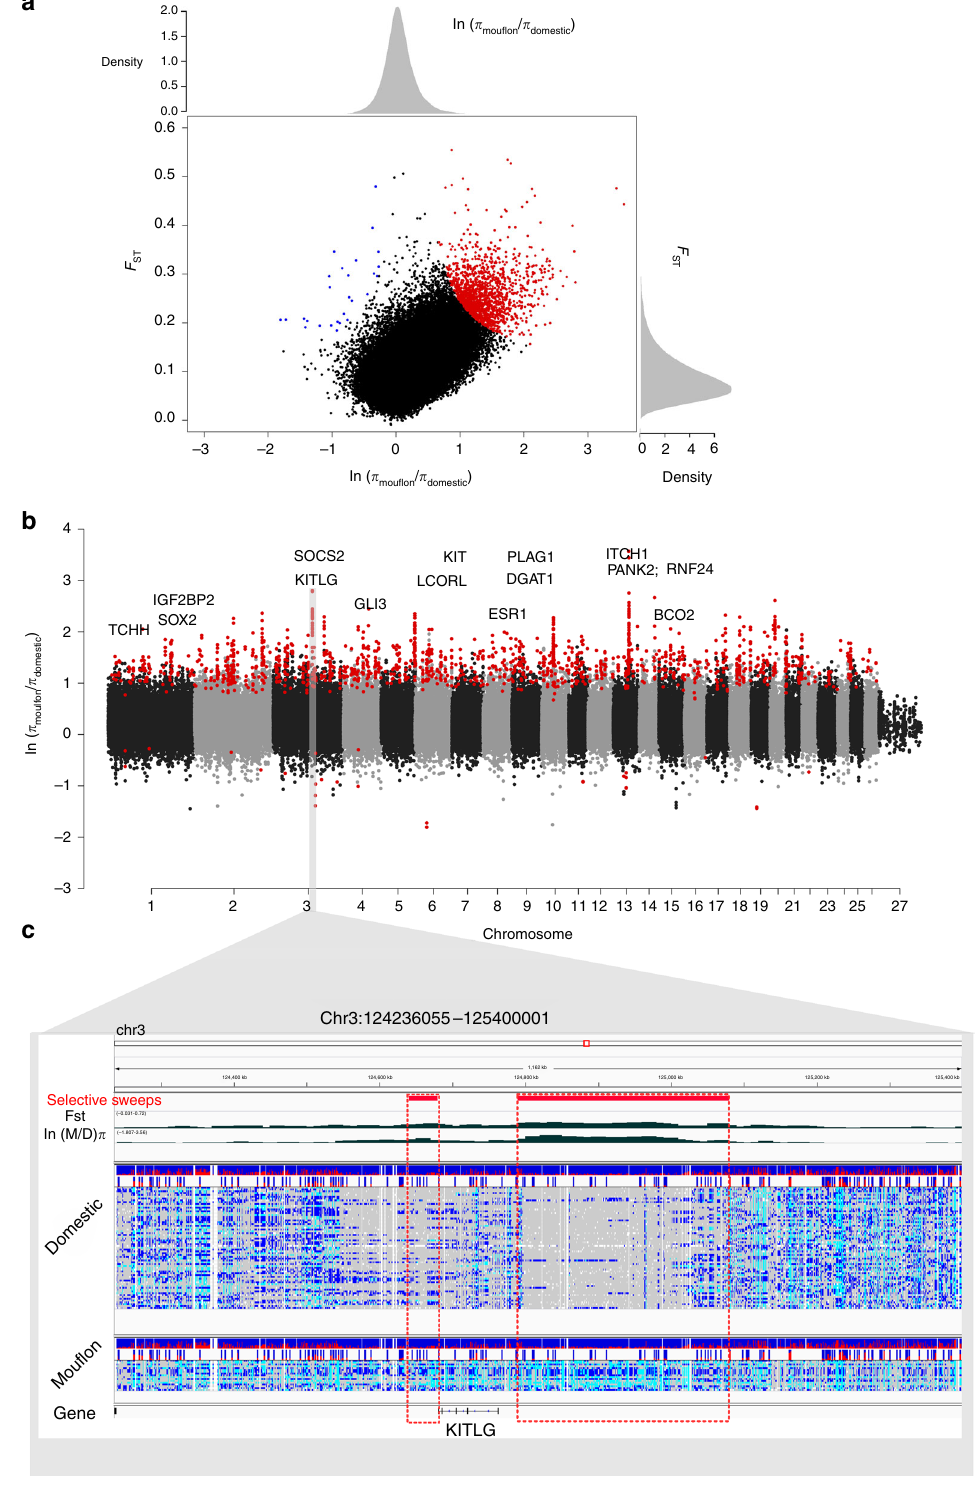
Fig. 2 Genomic regions putatively under positive selection in sheep. a Population differentiation ( F ST ) and relative nucleotide diversity between wild and domestic sheep ( π mou fl on / π domestic ) was estimated in 20 kb genomic bins. A total of 1420 outlier bins exhibiting evidence for selection in domestic sheep genomes are indicated in red (corresponding to Z -test P < 0.001, where F ST > 0.156 and ln ratio > 0.672). b Genome-wide distribution of relative nucleotide diversity. Positive values identify genomic bins with depressed diversity in domestic sheep compared with mou fl on, consistent with positive selection sweeps involved with domestication and selection (Table 1, Supplementary Table 4). c Selective sweeps located either side of KITLG coding exons. Integrated Genome Visualisation (IGV) screenshot of chromosome 3:124236035 – 125400001 illustrates the reduction of SNP variation in 67 domestic genomes compared with 17 Mou fl on. The two regions identi fi ed by our selection metrics are shown inside the dashed red